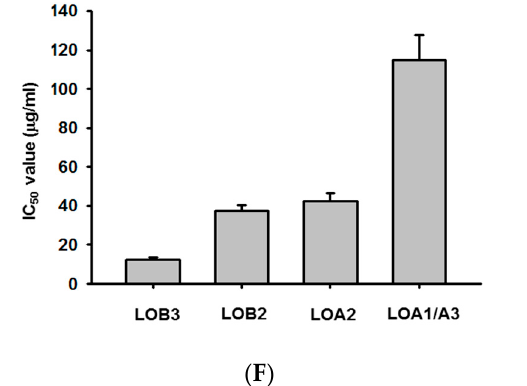
Figure 6. Anti-inflammatory effect of each linusorb in LOMIX. RAW264.7 cells pretreated with the indicated doses of either ( A left ) LOB3, ( B left ) LOB2, ( C left ) LOA2, ( D left ) LOB1, or ( E left ) LOA1/A3 for 30 min were treated with LPS (1 µg/mL) for 24 h, and NO level in the cell culture media was determined by Griess assay. RAW264.7 cells were treated with the indicated doses of either ( A right ) LOB3, ( B right ) LOB2, ( C right ) LOA2, ( D right ) LOB1, or ( E right ) LOA1/A3 for 24 h, and the cell viability was determined by MTT assay. ( F ) IC 50 values of LOB3, LOB2, LOA2, and LOA1/A3 for NO production. ## p < 0.01 compared to the vehicle-treated control. * p < 0.05, ** p < 0.01 compared to the stimulator-treated controls. Table 2. The composition of linusorb mixture (LOMIX) by